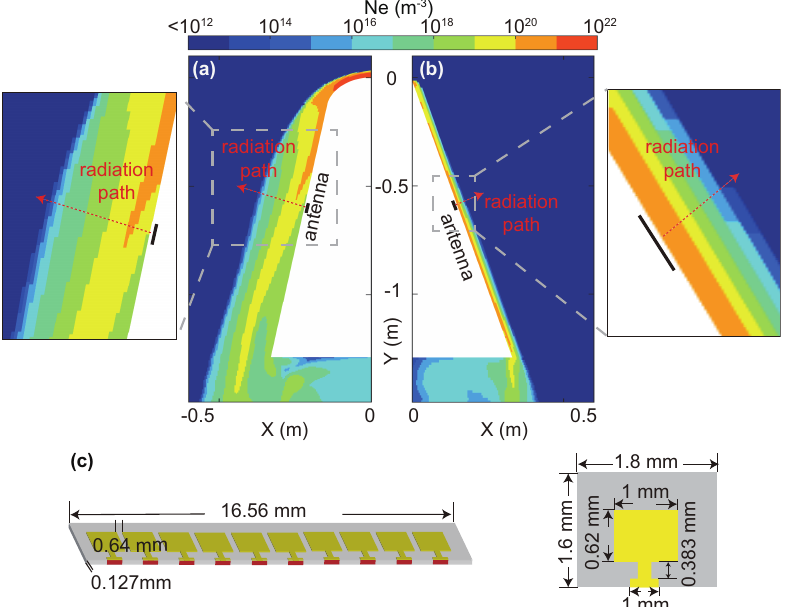
Figure 1. ( a ): The electron density distribution in the plasma sheath of the blunt-coned vehicle. The red arrow is the antenna radiation path. The left zoom area shows the plasma sheath layer distribution along the antenna radiation path in detail. The layers are not perpendicular to the radiation path. ( b ): The electron density distribution in the plasma sheath of the sharp-coned vehicle. The red arrow is the antenna radiation path. The right zoom area shows the plasma sheath layer distribution along the antenna radiation path in detail. The layers are perpendicular to the radiation path. ( c ): The structure of the 0.14 THz array